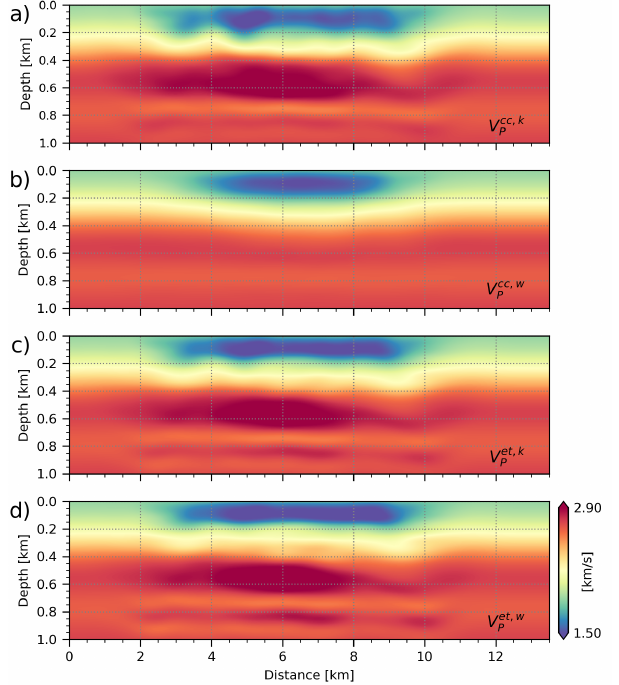
Figure 13. ( a , b ) show the inverted velocity models V cc , k and V cc , w by the traditional CC objective P P function with the correct Klauder wavelet and wrong source wavelet, respectively; ( c , d ) are the inverted velocity models V et , k and V et , w by the ET objective function with the correct Klauder wavelet P P and wrong source wavelet.